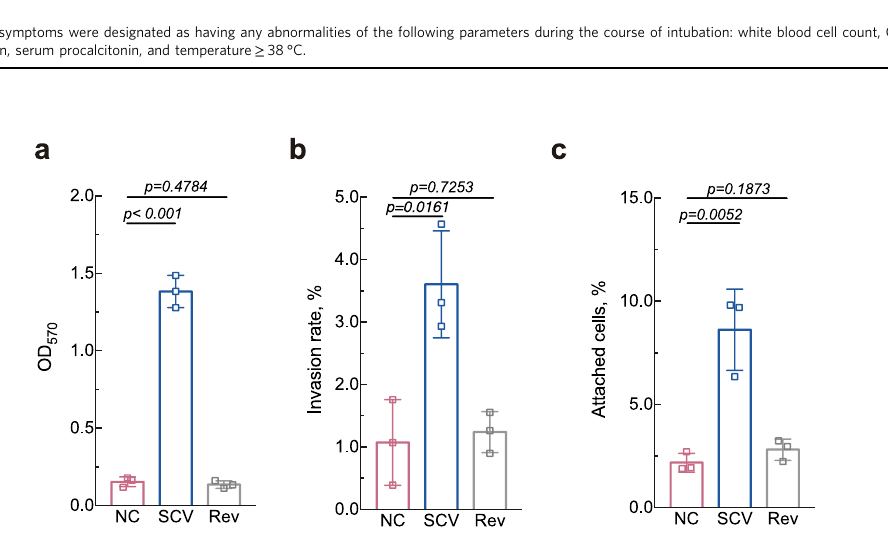
Fig. 2 Phenotypic alterations of the S. epidermidis stable SCV isolate recovered from a case of clinical intravenous catheter infection. a Bio fi lm elaboration measured using semiquantitative crystal violet staining. b Bacterial invasion assay with A549 cells. c Primary attachment to polystyrene surface. Statistical analyses were performed using Student ’ s t test after Shapiro – Wilk normality test. The data shown are mean ± SD of three biological